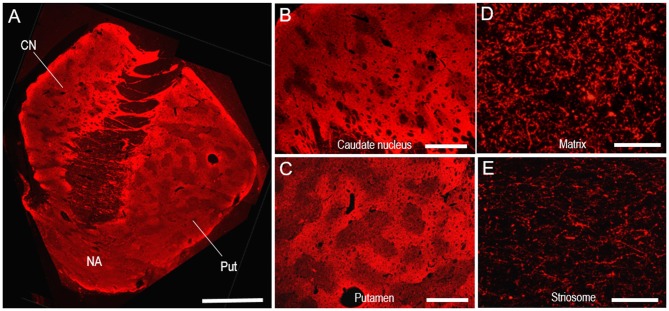
Neostriatal mosaic visualized by TH-immunostaining with Cyanine 3 in human brains. (A) A photomontage of a striatal section stained for TH. (B,C) Photomicrographs of the CN (B) and putamen (C) in the striatum stained for TH. (D,E) Photomicrographs of areas stained for TH in the matrix (D) and striosome (E) of the putamen. Abbreviations: CN, caudate nucleus; Put, putamen; NA, nucleus accumbens. Scale bars: (A) 5 mm, (B,C) 2 mm, (D,E) 50 μm.